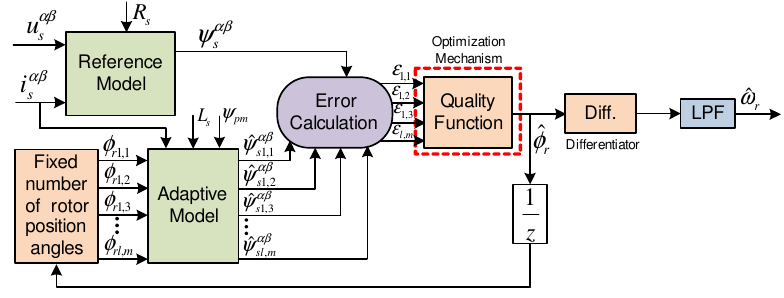
Figure 4. Structure of the proposed MRAS-FS observer for control of SMPMSGs without mechanical